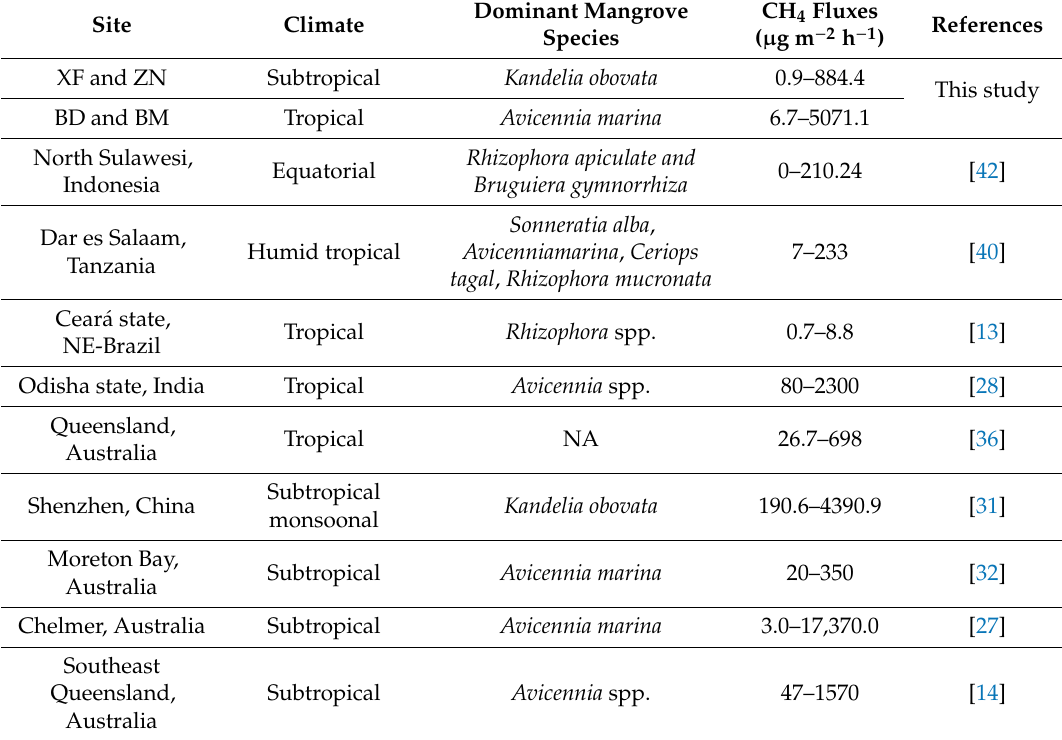
Table 6. Comparisons of soil CH 4 flux in the mangroves of this study and other